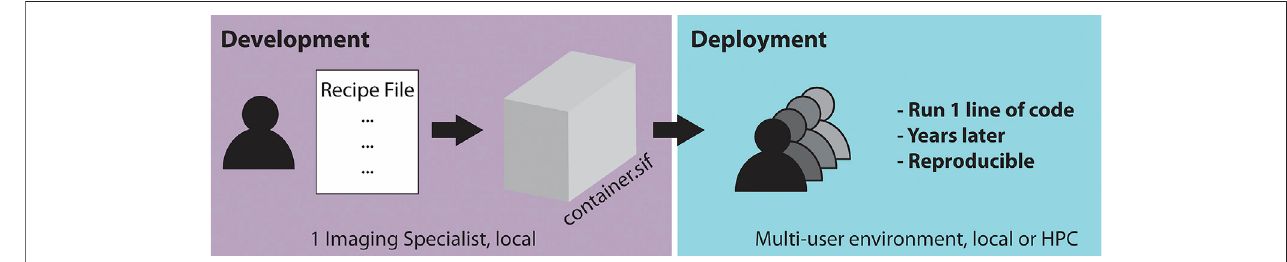
FIGURE 1 | Schematic of a two-step work fl ow for the usage of containers: “ build once, apply forever.